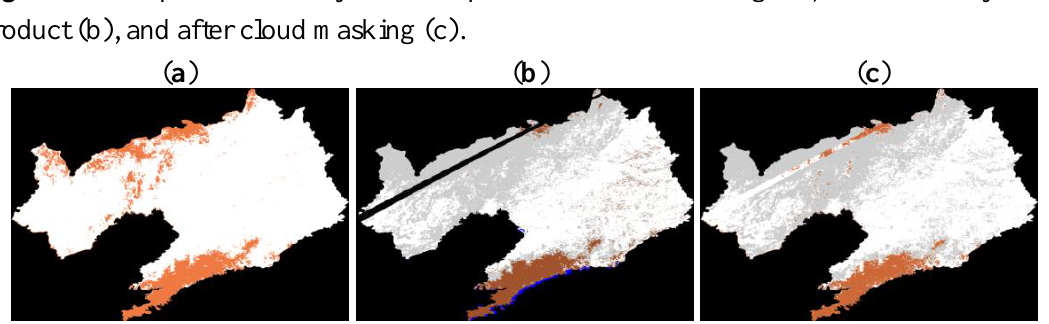
Figure 7. Comparison of daily snow maps before cloud masking (a), MODIS Daily Snow Product (b), and after cloud masking